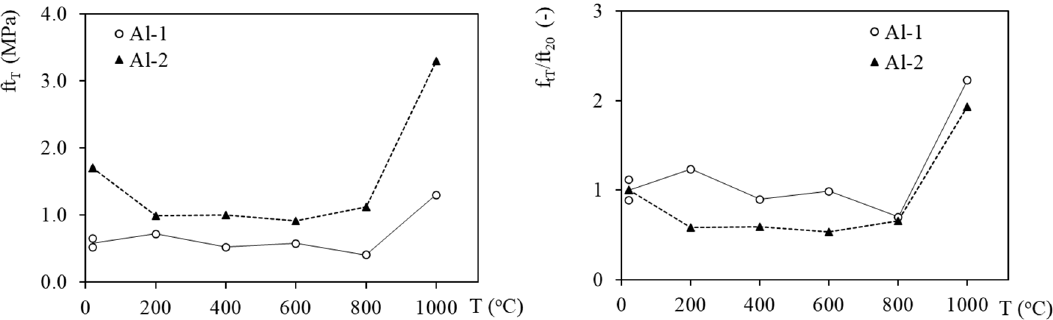
Figure 8. Tensile strength of heated geopolymer foams: absolute values in MPa and relative f tT /f t20 values [-].